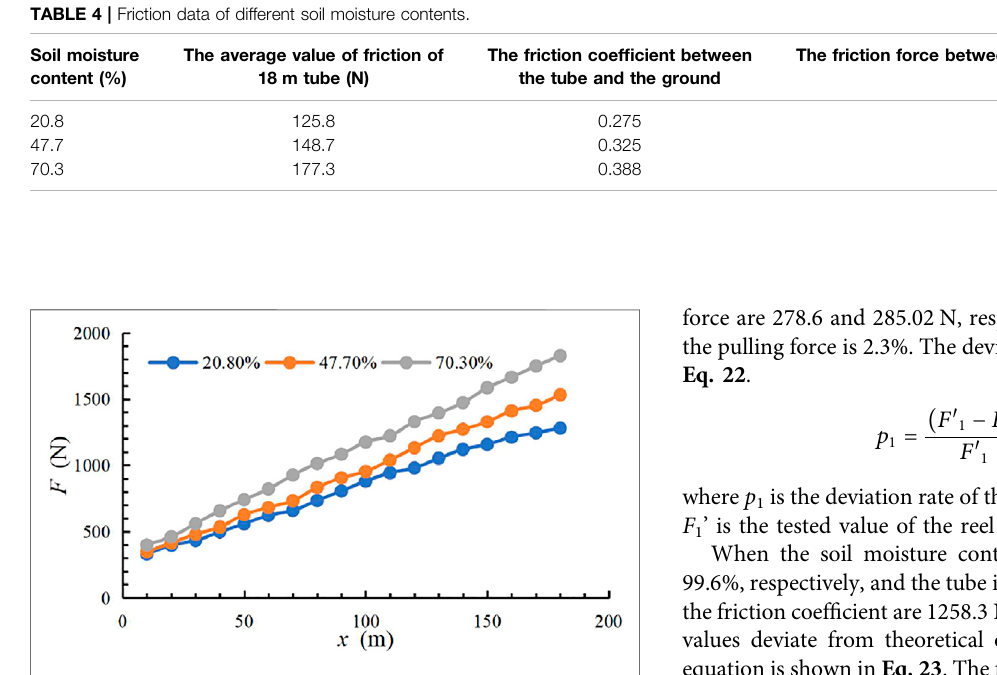
FIGURE 10 | The total pulling force of the reel and the